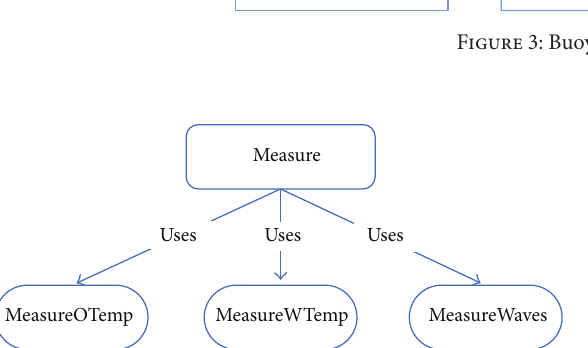
Figure 4: Measure data capability.